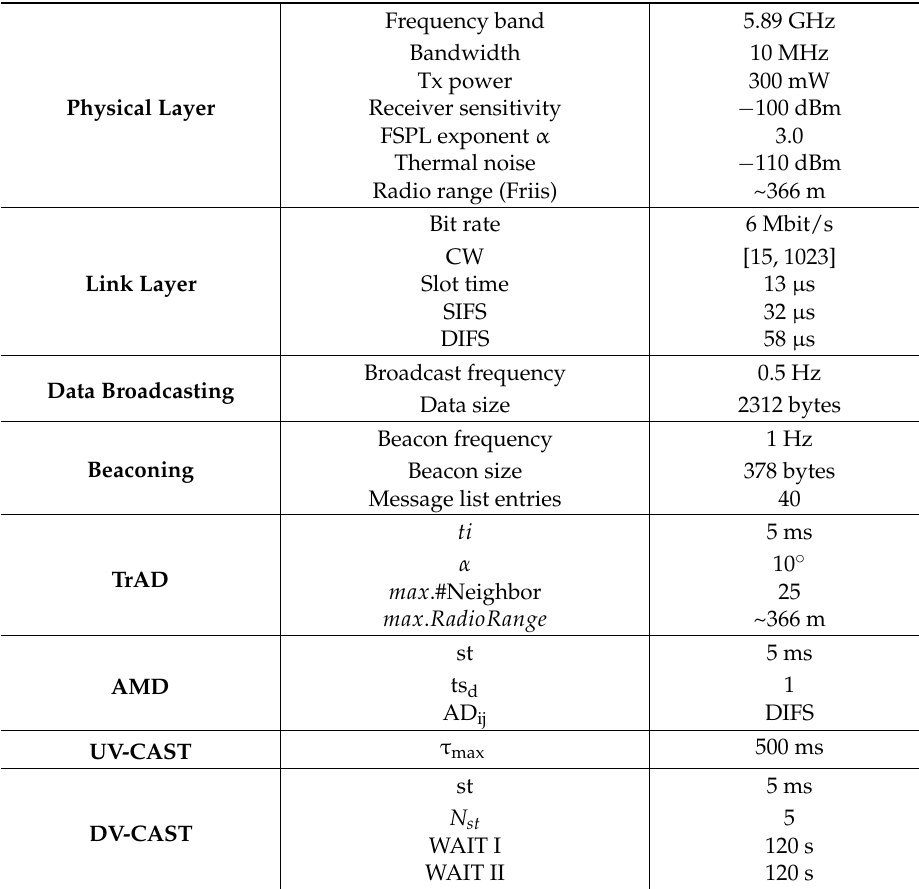
Table 1. Simulation